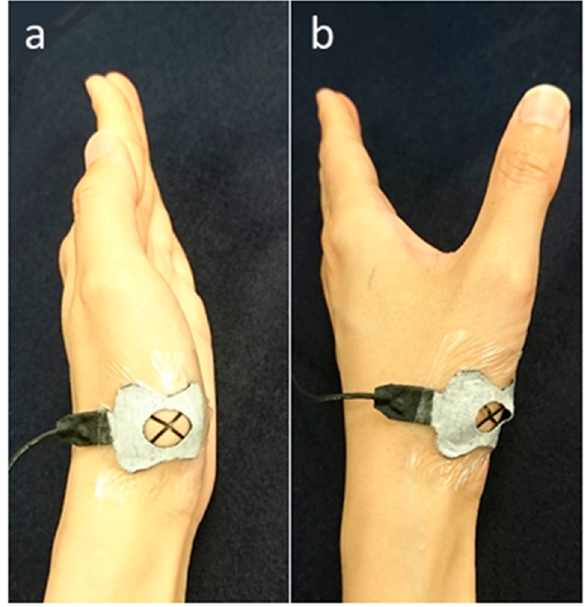
Figure 2. Attachment site of the sensor and position of the thumb during measurement: ( a ) adduction and ( b ) palmar abduction.